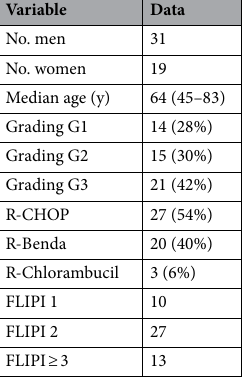
Table 1. Patient characteristic.